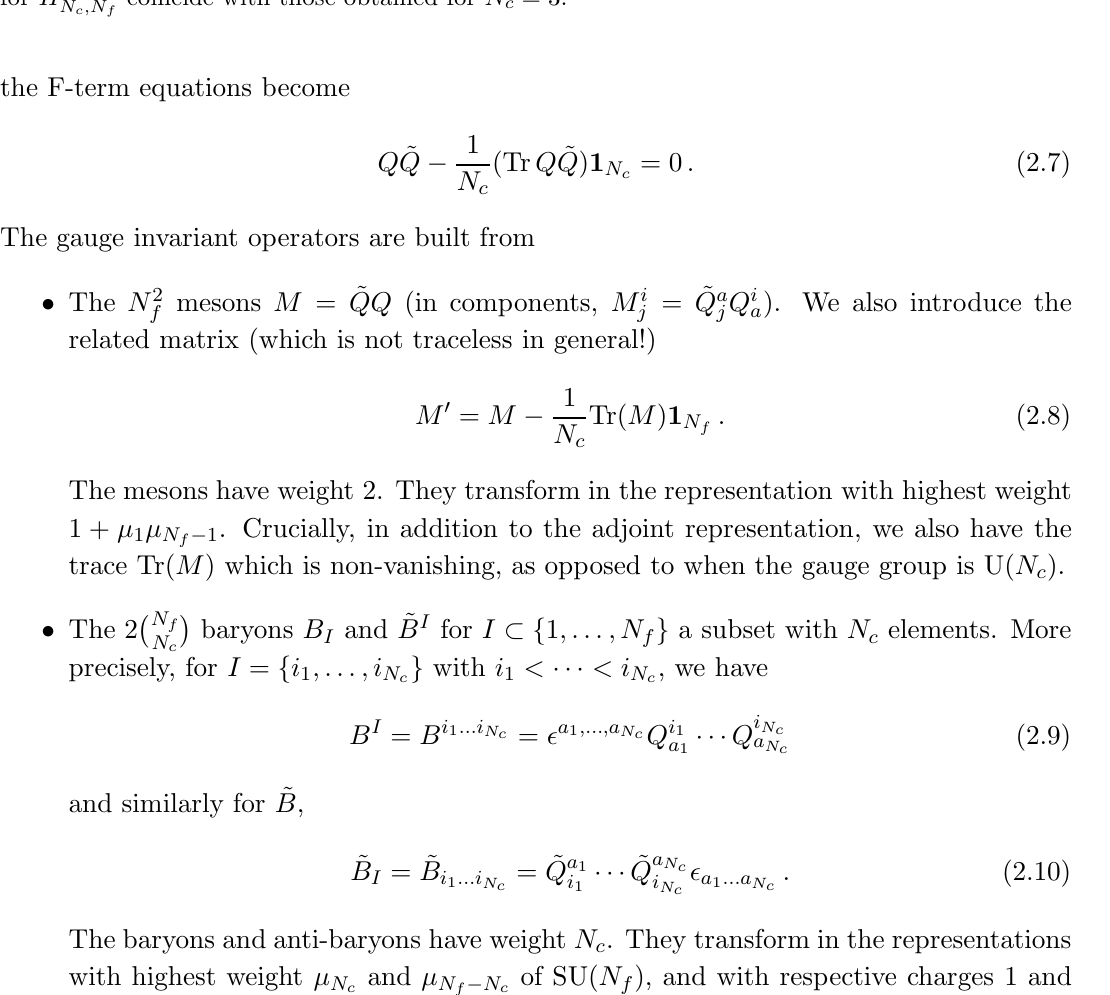
Table 3 . Hilbert series for U(3) with n flavors. For the U( N c ) theories with N c for H U coincide with those obtained for N c = N c ,N f